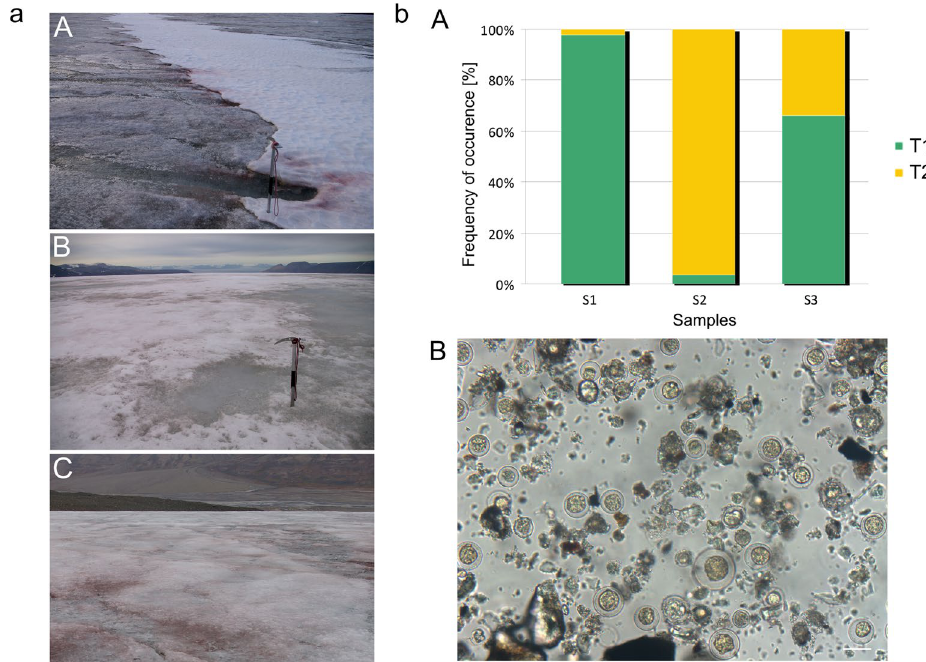
Figure 1. (a) Red snow and ice sampling sites in Svalbard: A—Longyearbreen Glacier, B—Upper Foxfonna Glacier (elevation 789 m), C—Lower Foxfonna Glacier (elevation 609 m). (b) A—Abundances of two morphological forms of S. nivaloides : T1—cysts, and T2—hypnozygotes in three sites: S1 (A), S2 (B), S3 (C); B—microscopic image of fixed algal cells from Longyearbreen Glacier. Scale: 20 µm. Pictures were taken by Nozomu